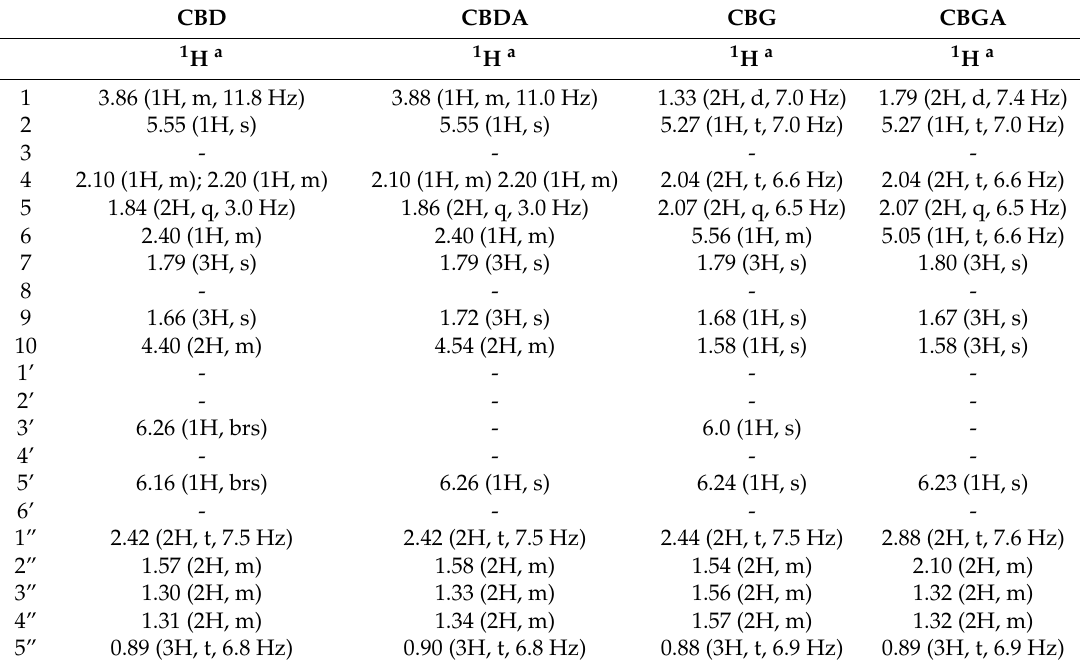
Table 1. 1 H assignments for hemp cannabinoids in CDCl 3.